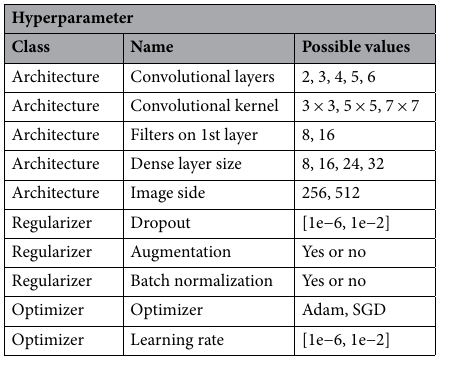
Table 1. Hyperparameters of the